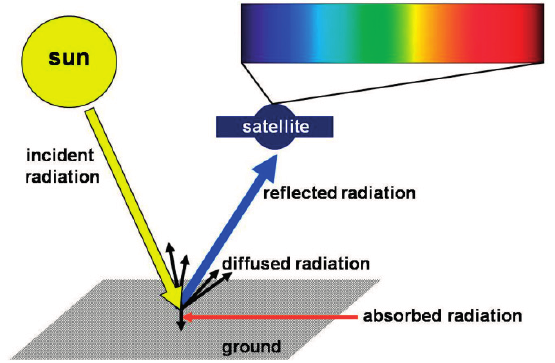
Figure 1. Scheme of the remote sensing principle. A fraction of sunlight reflected or scattered by the soil is detected at selected wavelengths by the